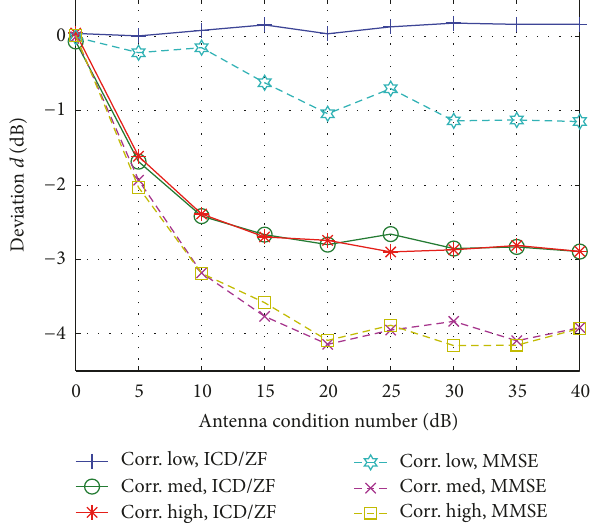
Figure 12: Deviation 𝑑 versus antenna condition number for DLSCH processing off, nonideal channel estimation; low, medium, and high channel correlation; ICD/ZF and MMSE receiver.